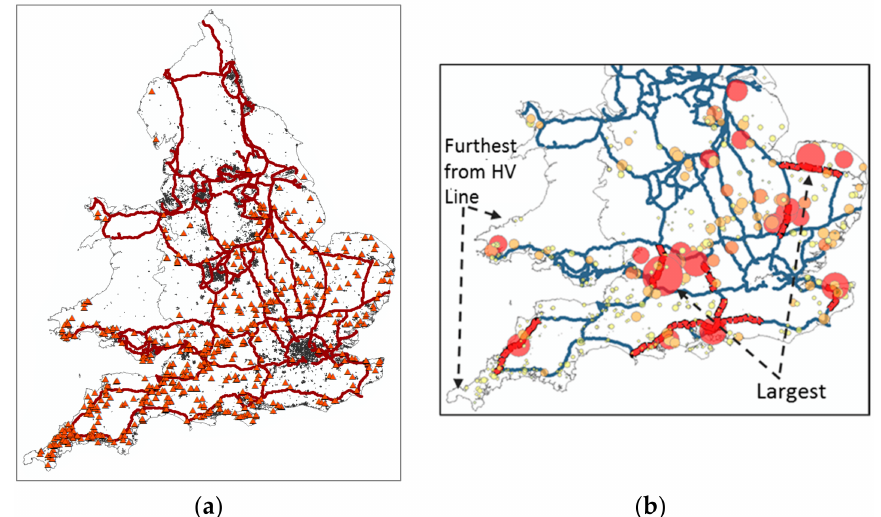
Figure 3. Solar farms, high voltage power lines, and large urban areas in the UK. ( a ) Solar farms compared to location of high voltage lines; ( b ) size of solar